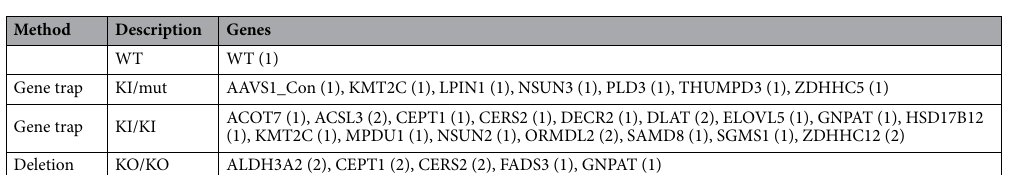
Table 1. Overview of knockout methods, genotypes, and cell lines created, as indicated by the 23 knocked out genes as well as AAVS1 control and WT cell lines. The number of clonal cell lines are indicated in